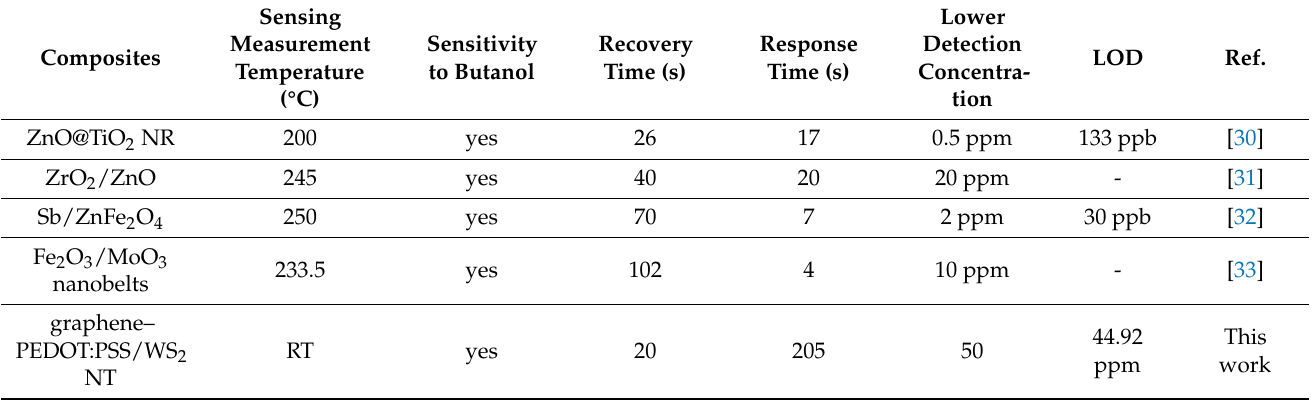
Figure 6. Sensitivity calibration curve for butanol at different concentrations for paper-based gra- phene–PEDOT:PSS/WS 2 nanotube chemiresistor. graphene–PEDOT:PSS/WS 2 nanotube chemiresistor. Table 1. Comparison of sensing parameters with other literature and present